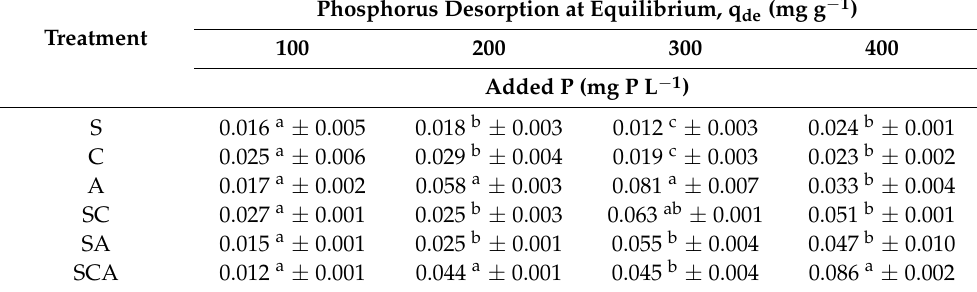
Table 6. Effects of treatments on the amounts of phosphorus desorbed at equilibrium at different concentrations of added phosphorus. Phosphorus Desorption at Equilibrium, q de (mg g − 1 Treatment